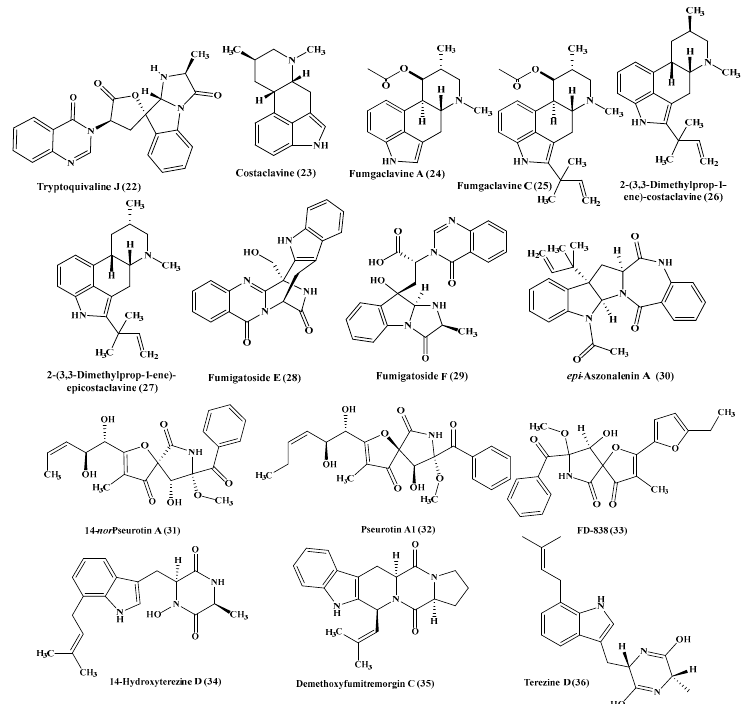
Figure 2. Alkaloids isolated from Aspergillus fumigatus.